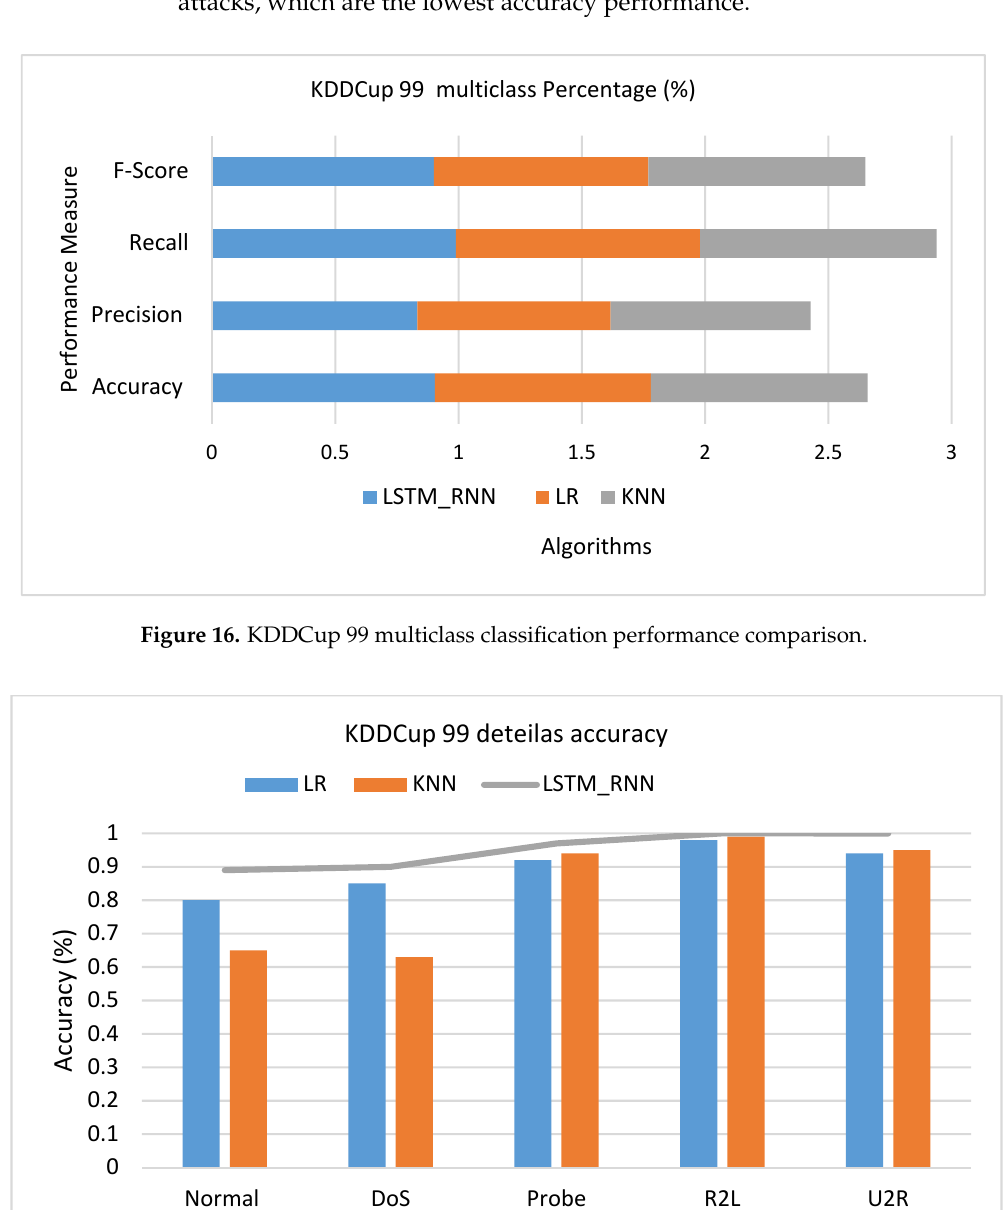
Figure 15. KDDCup 99 Binary classification performance comparison.